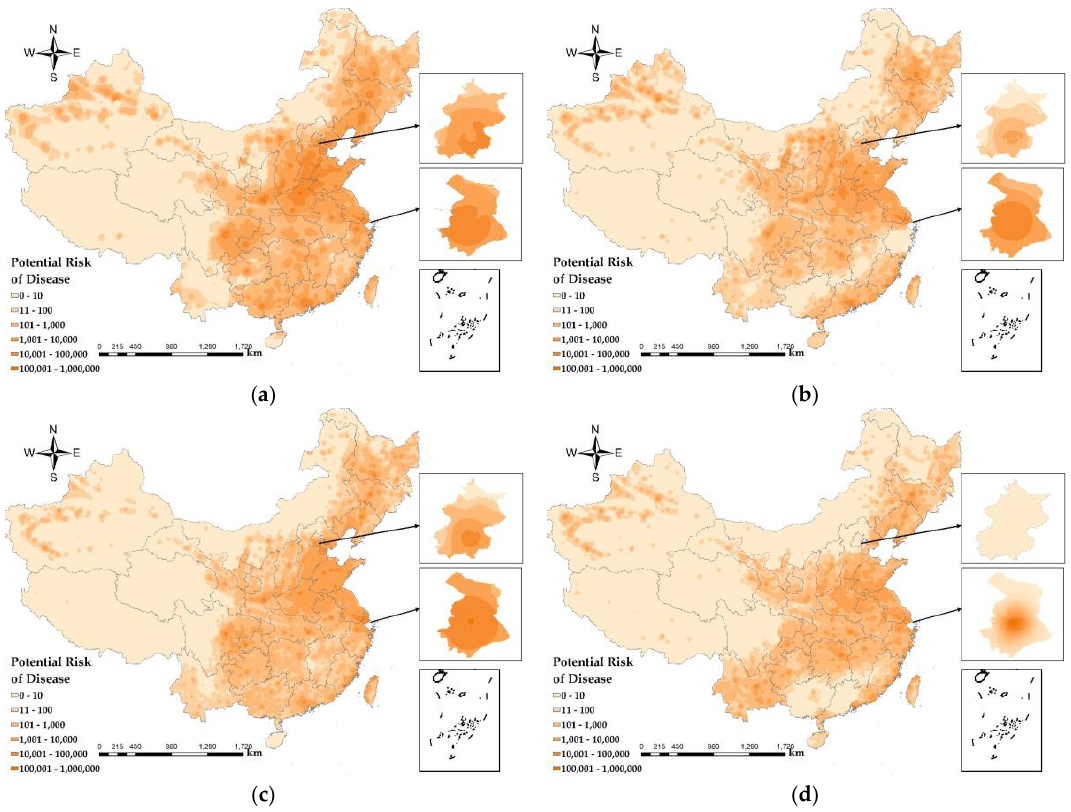
Figure 8. PM 2.5 health risks assessment. ( a ) 25 December 2019; ( b ) 11 January 2020; ( c ) 7 March 2020; and ( d ) 3 April 2020.